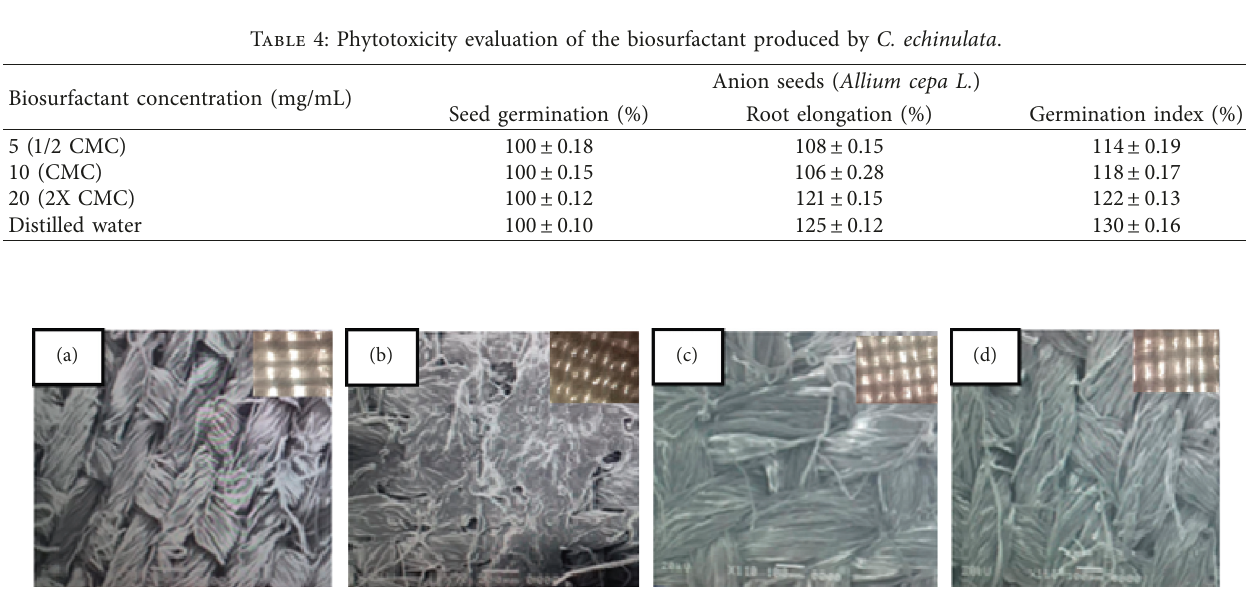
Figure 6: Cleaning and degreasing of stain of burned engine oil in cotton fabric by biosurfactant of C. echinulata comparing with commercial detergent: (a) clean fabric; (b) fabric with burned engine oil; (c) fabric washed with commercial detergent, and (d) fabric washed with biosurfactant of C. echinulata